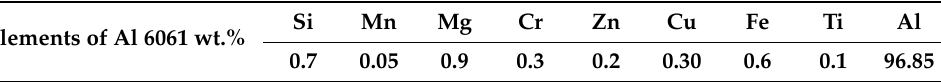
Table 1. Chemical weight composition of Al